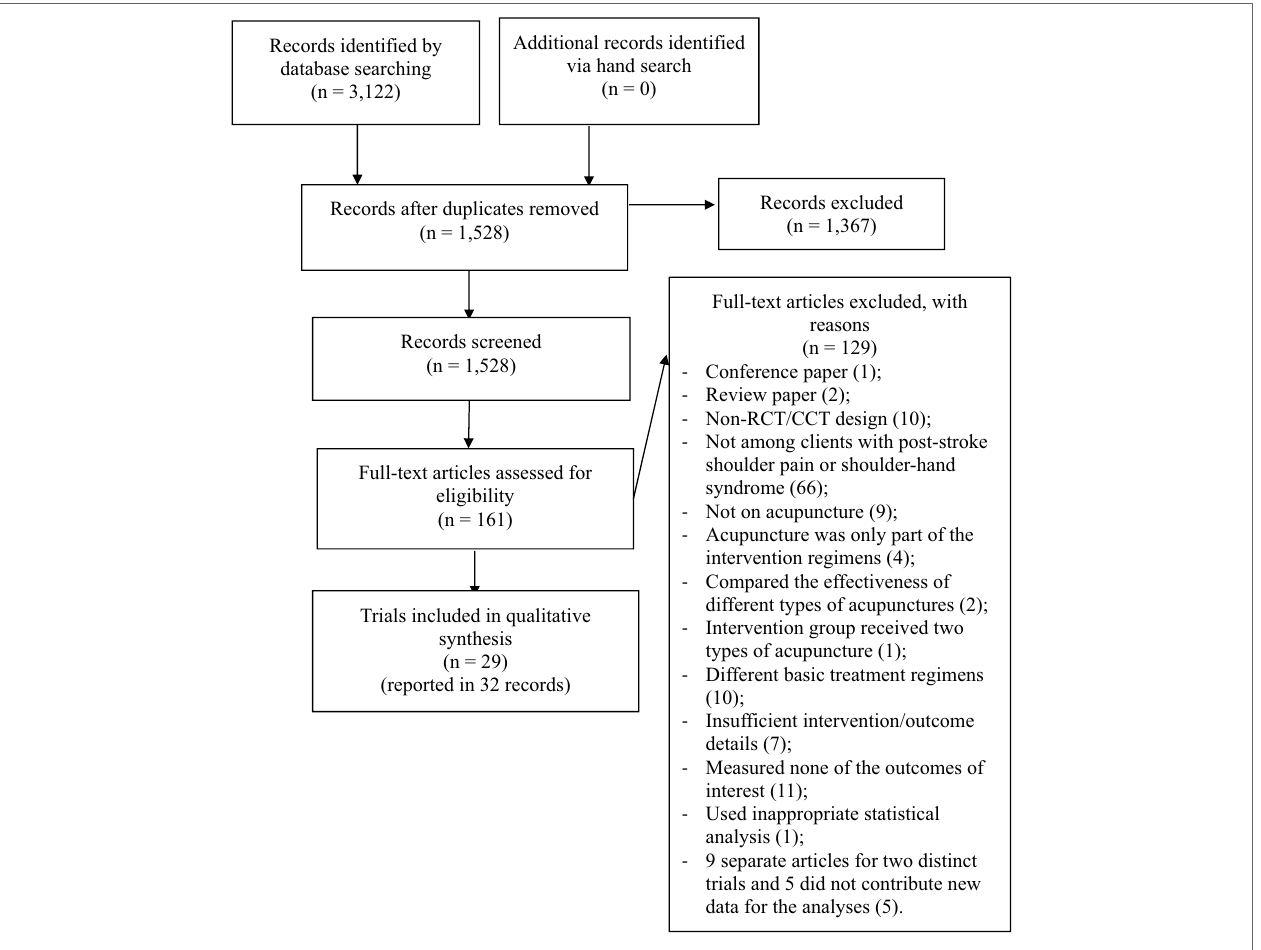
FigURe 1 | Preferred reporting items for systematic reviews and meta-analysis flow diagram of included